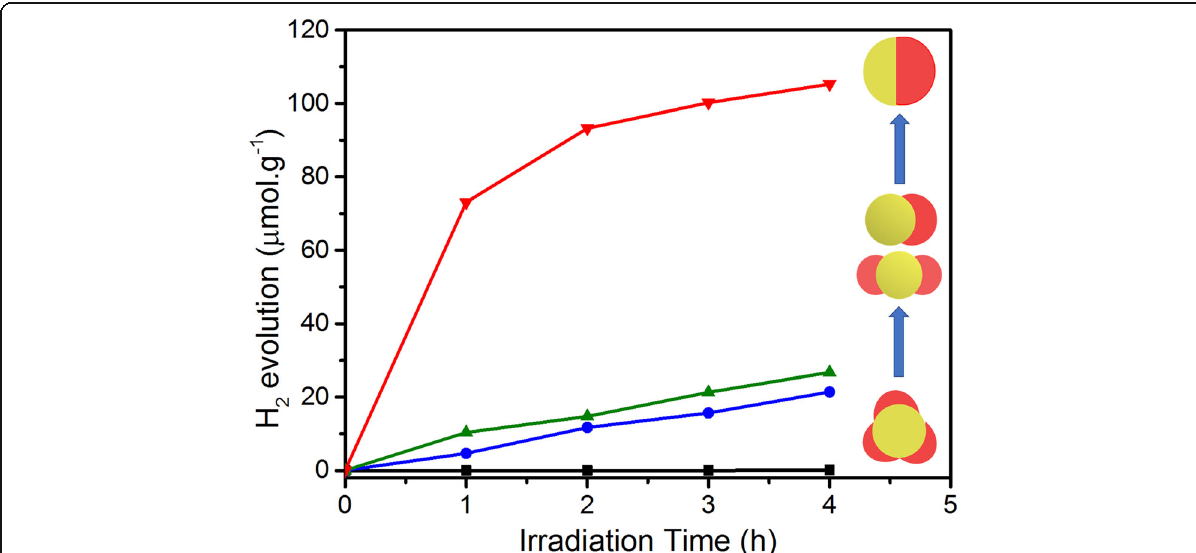
Fig. 7 Photocatalytic activity of four different types of Au/CdSe hybrid nanoparticles such as Janus nanospheres, heterodimers, symmetric double- headed nanoparticles, multi-headed nanoparticles for H 2 production